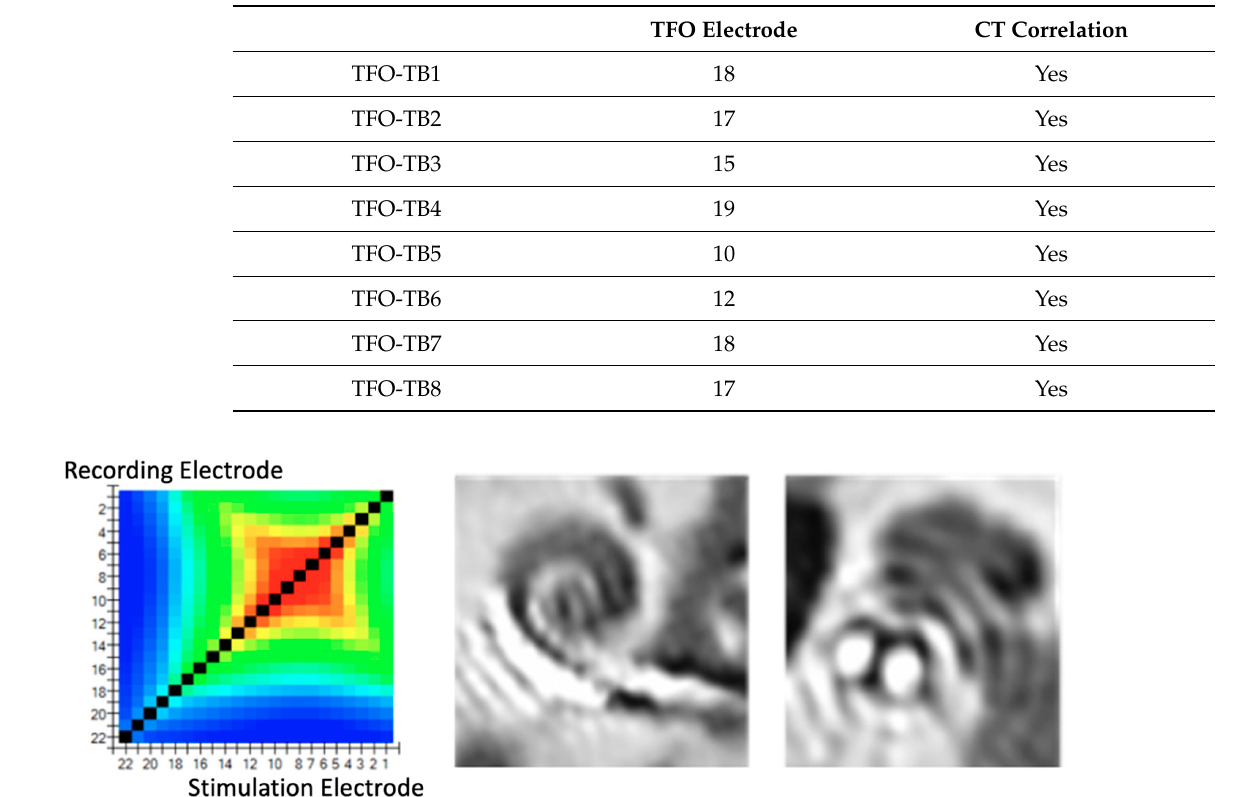
Table 3. Intentional TFO insertion in all temporal bones. In all TB, the TIM pattern showed a “fold-over” effect, with a complete correlation with fold-over detection using CT scan.